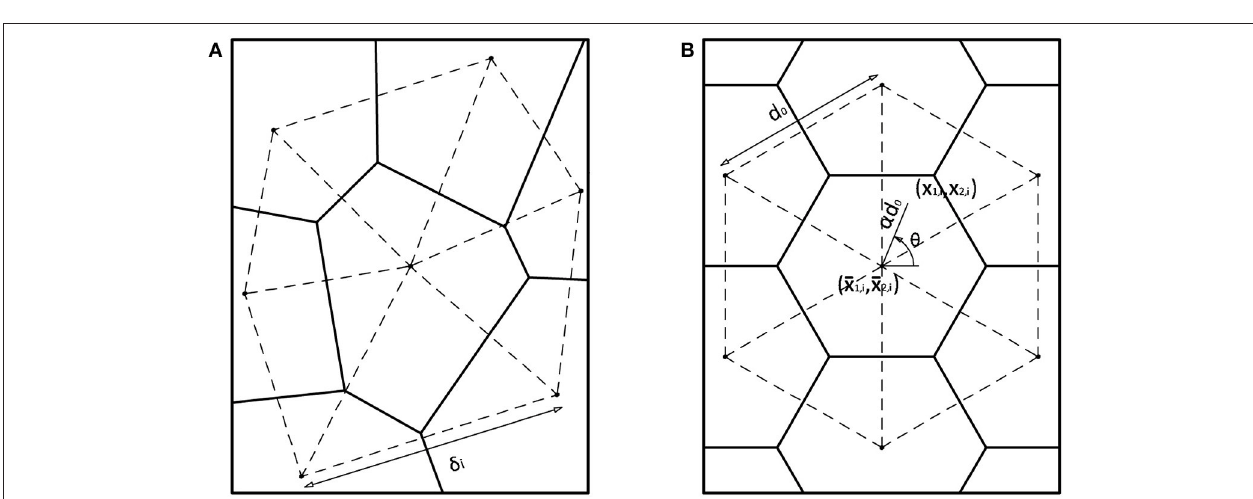
Frontiers in Built Environment |